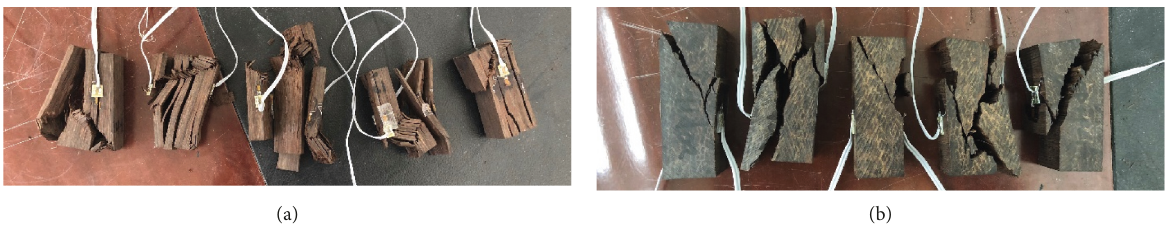
Figure 5: Failure modes of the bamboo scrimber under compression. (a) Parallel to grain. (b) Perpendicular to grain.